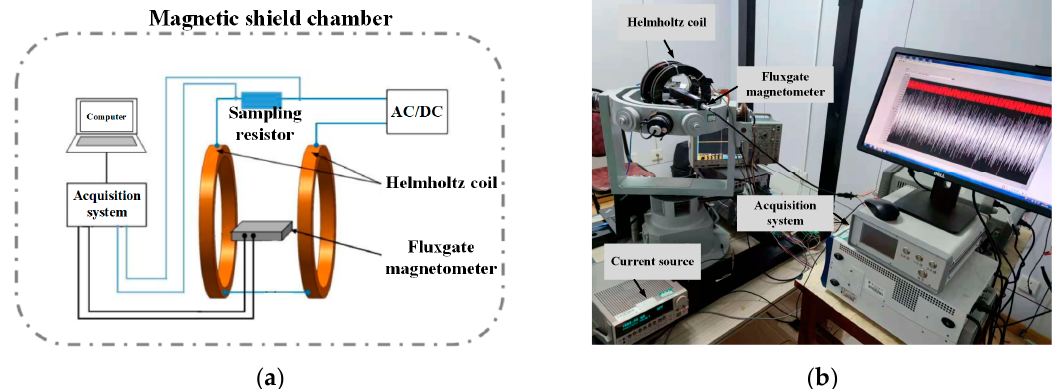
Figure 1. Dynamic characteristic test system for the magnetometer: ( a ) sketch diagram of the system; ( b ) photo of the real system with experimental apparatus.